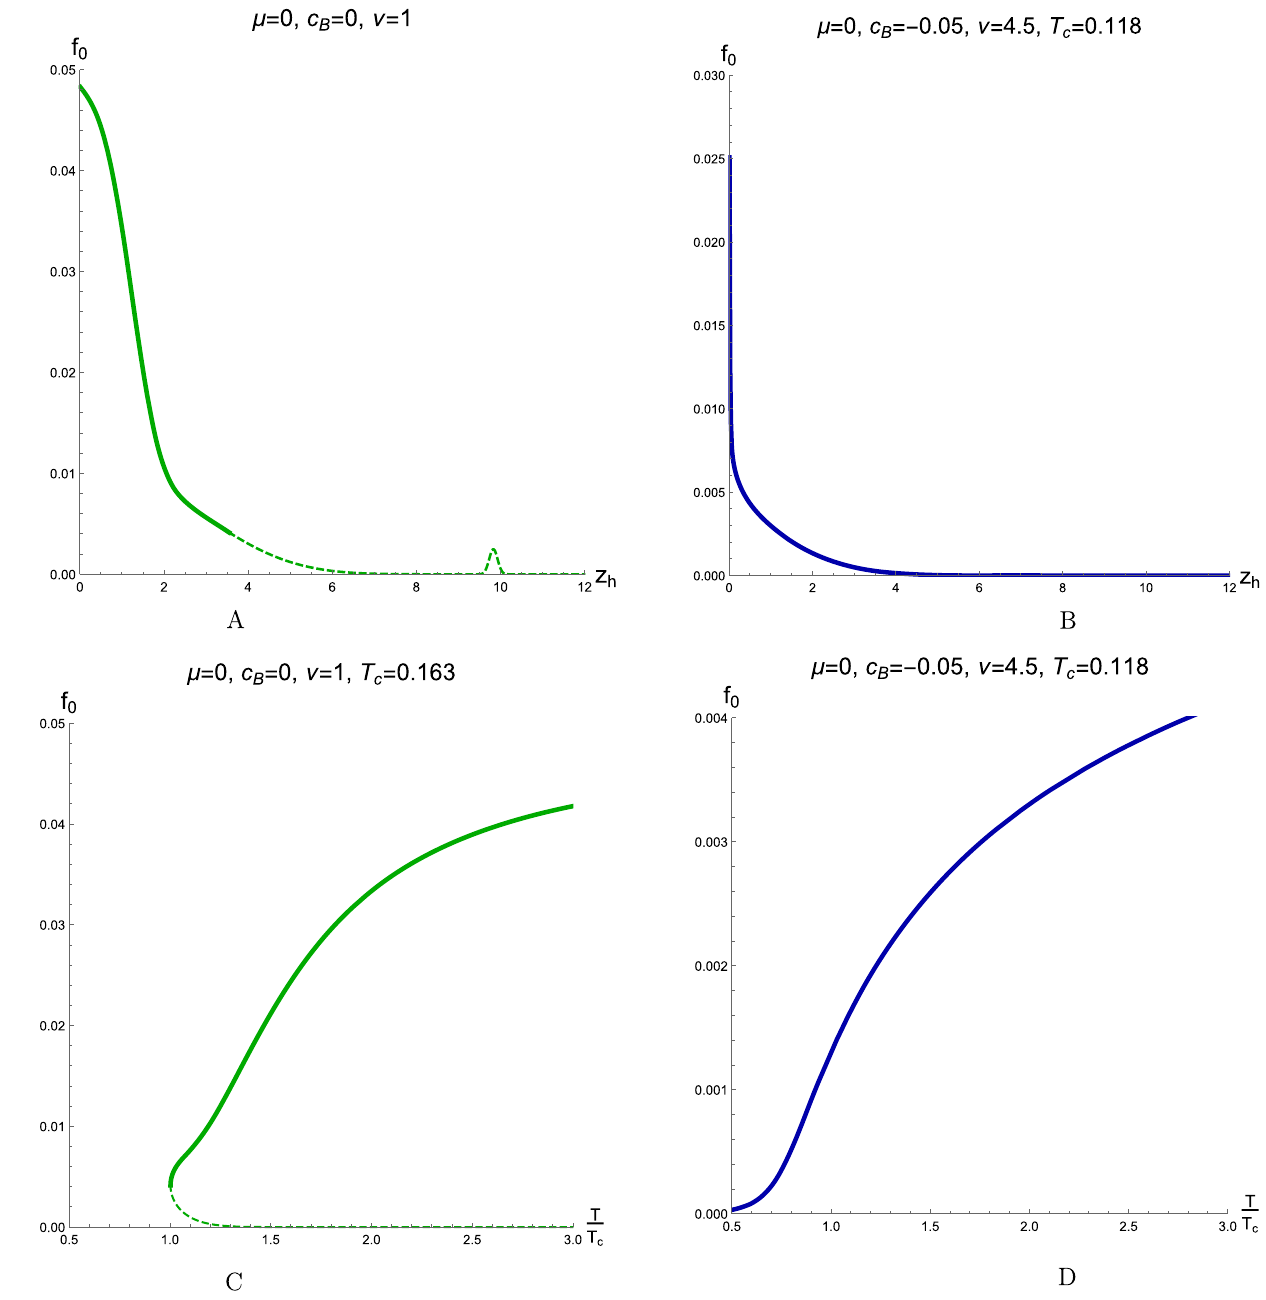
Fig. 4 The dependence of our choice of f 0 function (4.4) on the size of the horizon ( A , B ) and on the temperature T / T c ( C , D ) for isotropic case (green curves) and anisotropic one (dark blue curves)